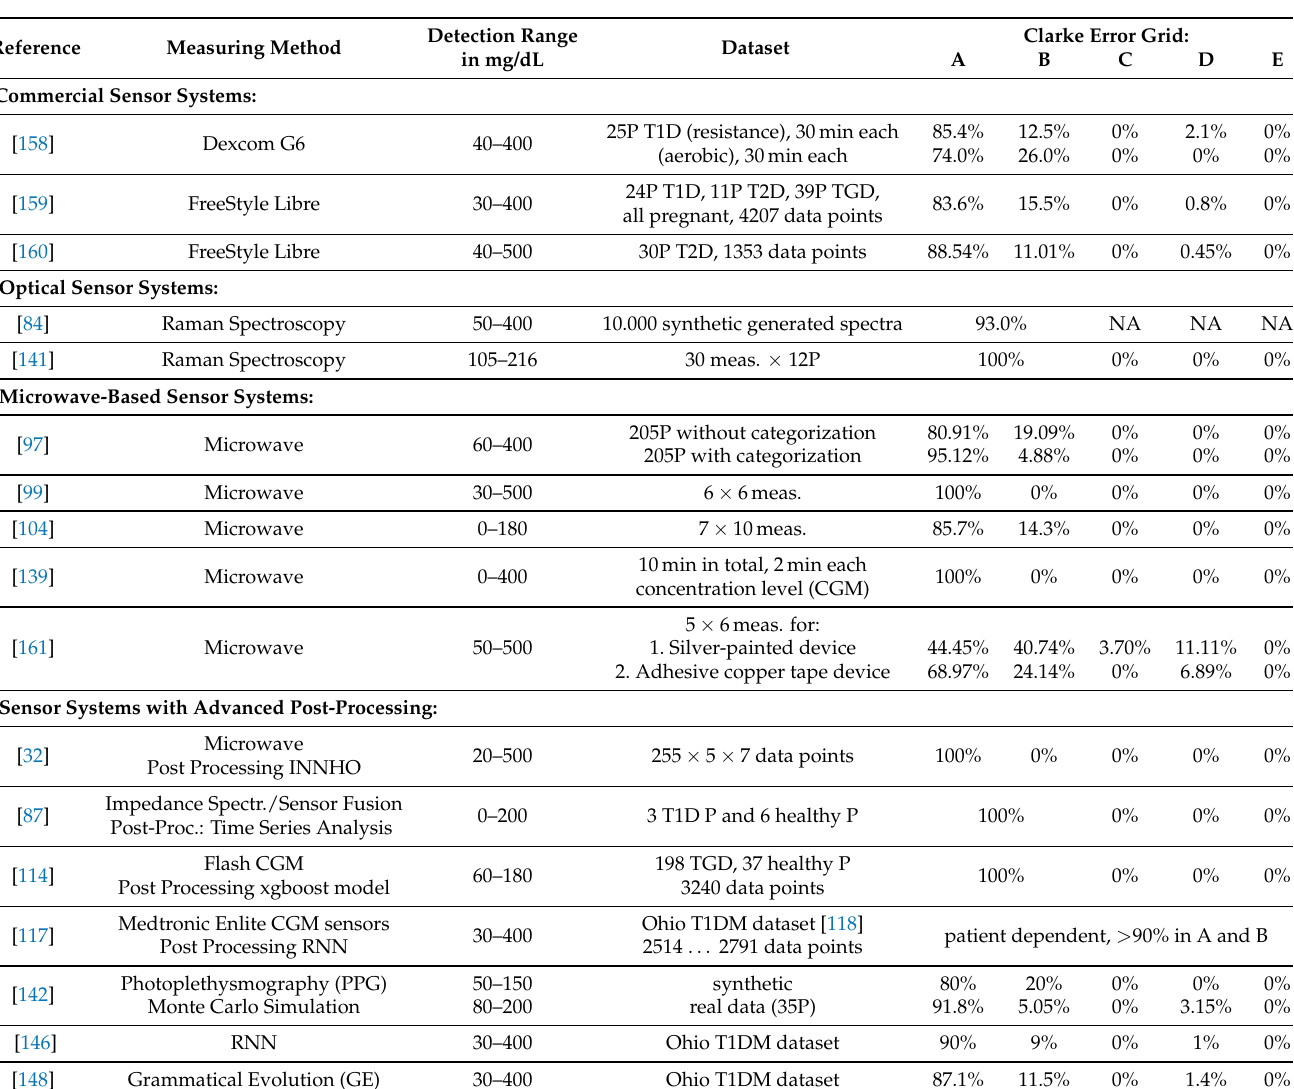
Table 12. Overview of the accuracy according to the Clarke error grid. Abbreviations: P = Persons, T1D = diabetes mellitus type 1, T2D = diabetes mellitus type 2, TGD = gestational diabetes mellitus, NA = Not a